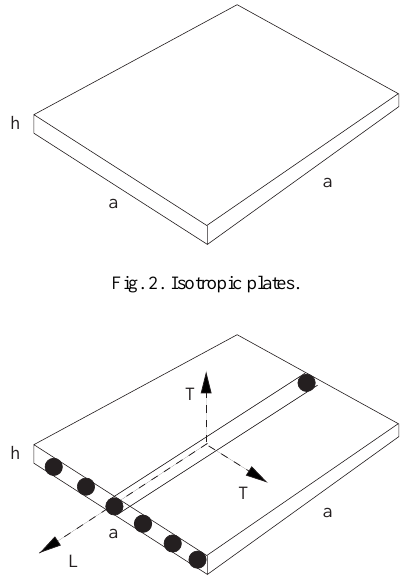
Fig. 3. Composite plate made of an orthotropic